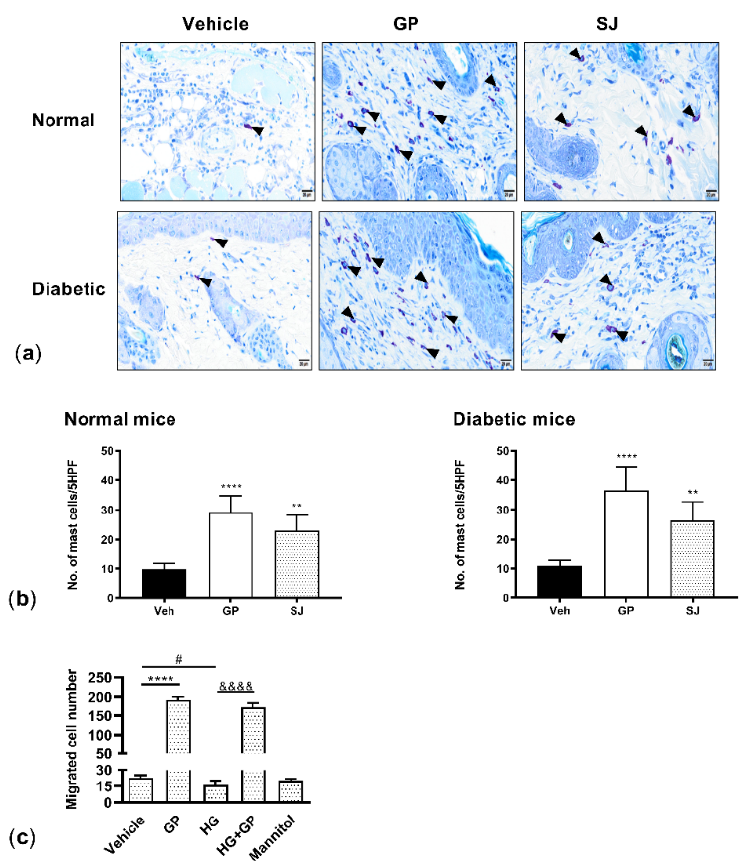
Figure 6. G. procumbens increases mast cell accumulation at wound sites and induces chemotaxis of LAD2 cells: Representative pictures of toluidine blue-stained wounds on ( a ) the normal and